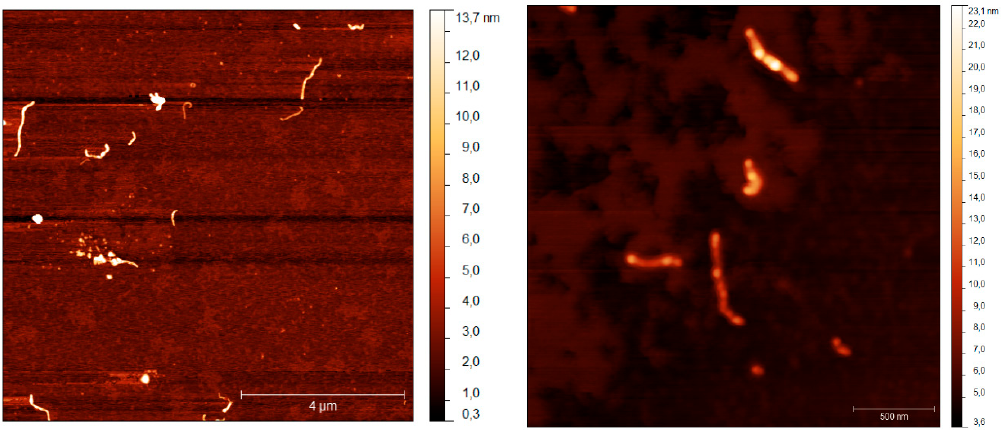
Figure 5. Optical micrographs of samples containing 0.0050 wt.% of 1/1 ss-DNA/CNT complexes and variable amounts of DDAB, at 25.0 °C. Magnification is 40× in pictures ( A – C ); 400× in ( D ). Figure ( A ) refers to 0.15; ( B) to 0.29; ( C ) and ( D ) to 0.098 mmol·kg − 1 , respectively. The red bar in the lower left hand side of the figure is 1.0 mm large.